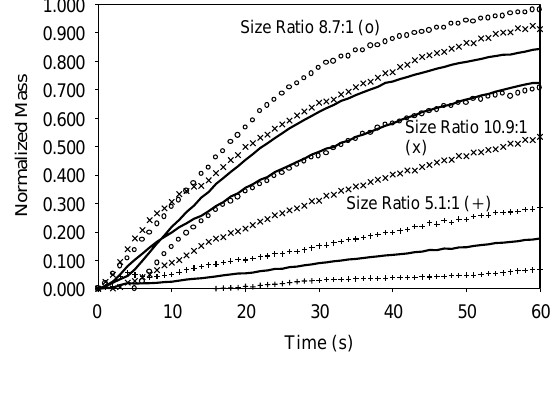
Fig. 7 Mean (solid lines) and 95% CI (symbols) for normalized mass as a function of time (cid:4) Strain (cid:6) 10%, Cycle Speed (cid:6) 0.75 cycles/second and Bed Depth (cid:6) 2.54